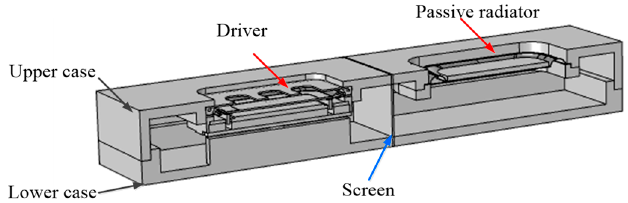
Figure 11. Screen in enclosure.